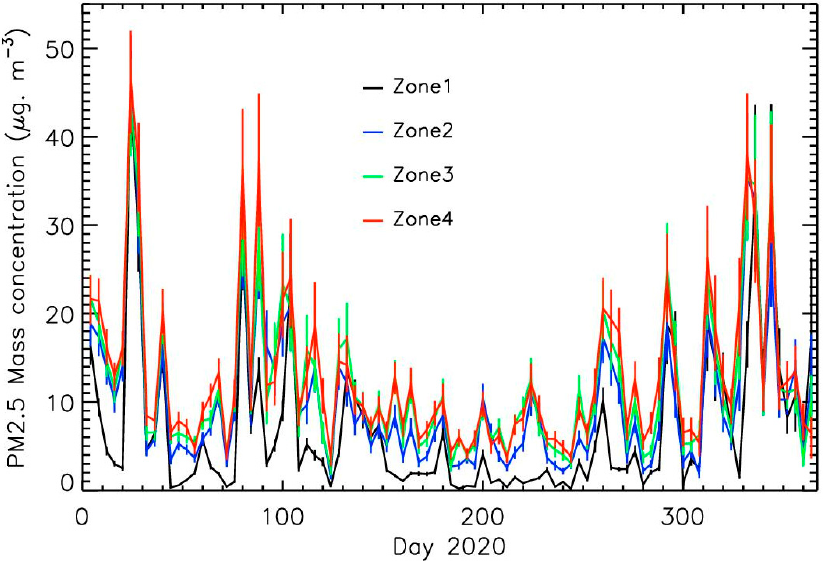
Figure 12. Temporal evolution of the PM2.5 measurements for the 4 zones; the data are averaged over 4 days for clarity reasons.